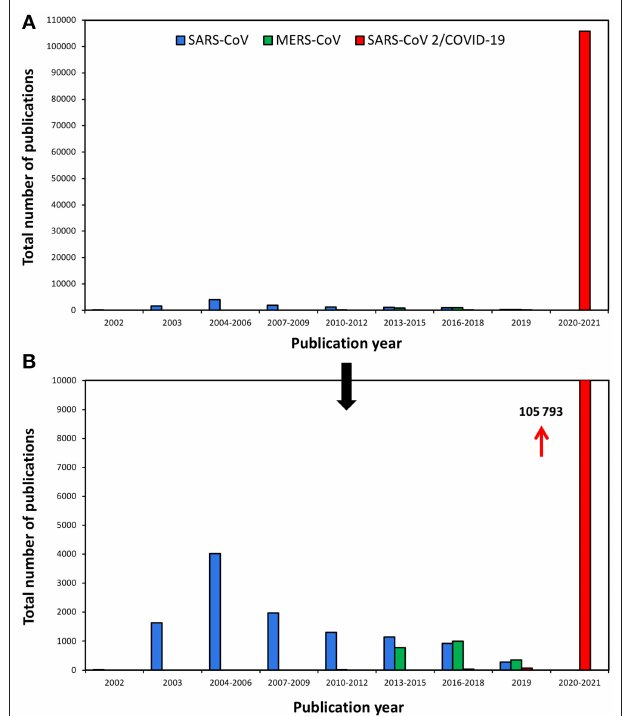
FIGURE 1 | Scientific production on SARS-CoV, MERS-CoV, and SARS-CoV 2/COVID-19 during the last two decades ( < 2002-2020) represented in two different scales: up to 110000 (A) and 10000 publications (B)